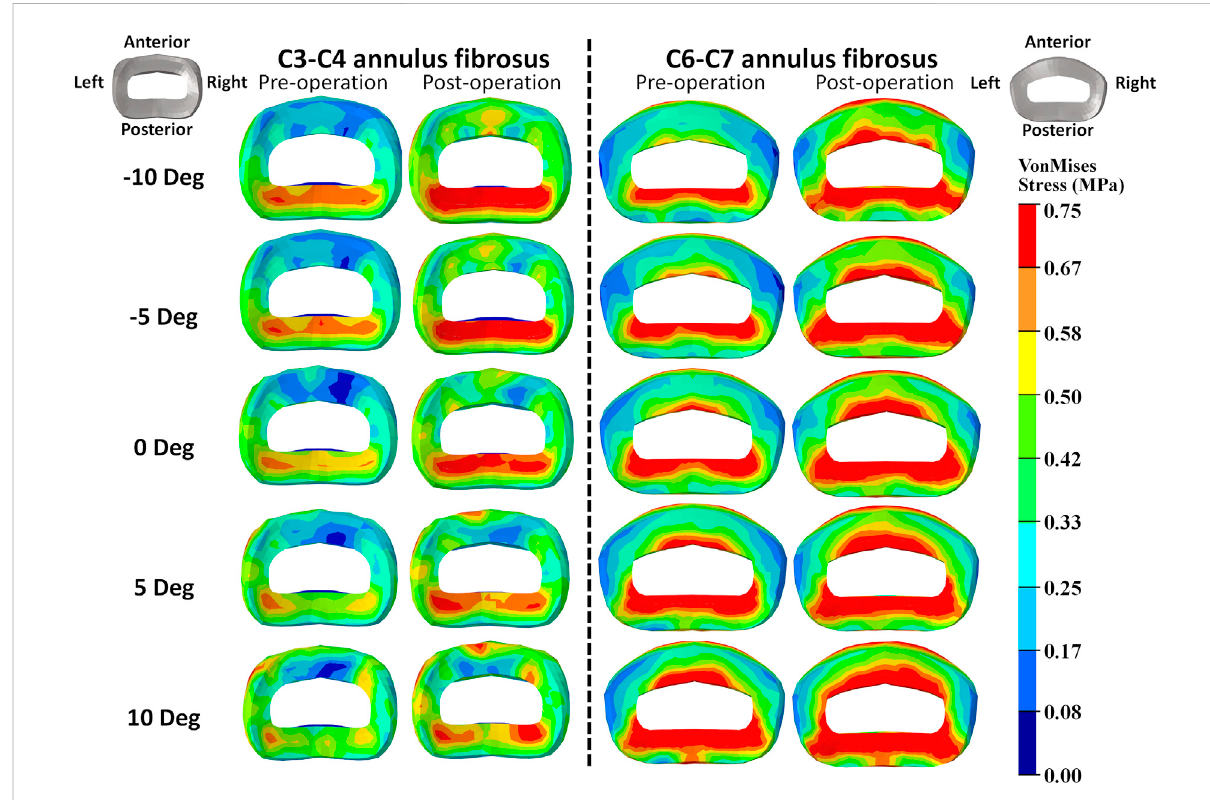
FIGURE 4 Annulus fi brosus VonMises stress distribution of C2 – T1 pre- and postoperative FE models with different T1 tilts under the 30 ° fl exion loading.